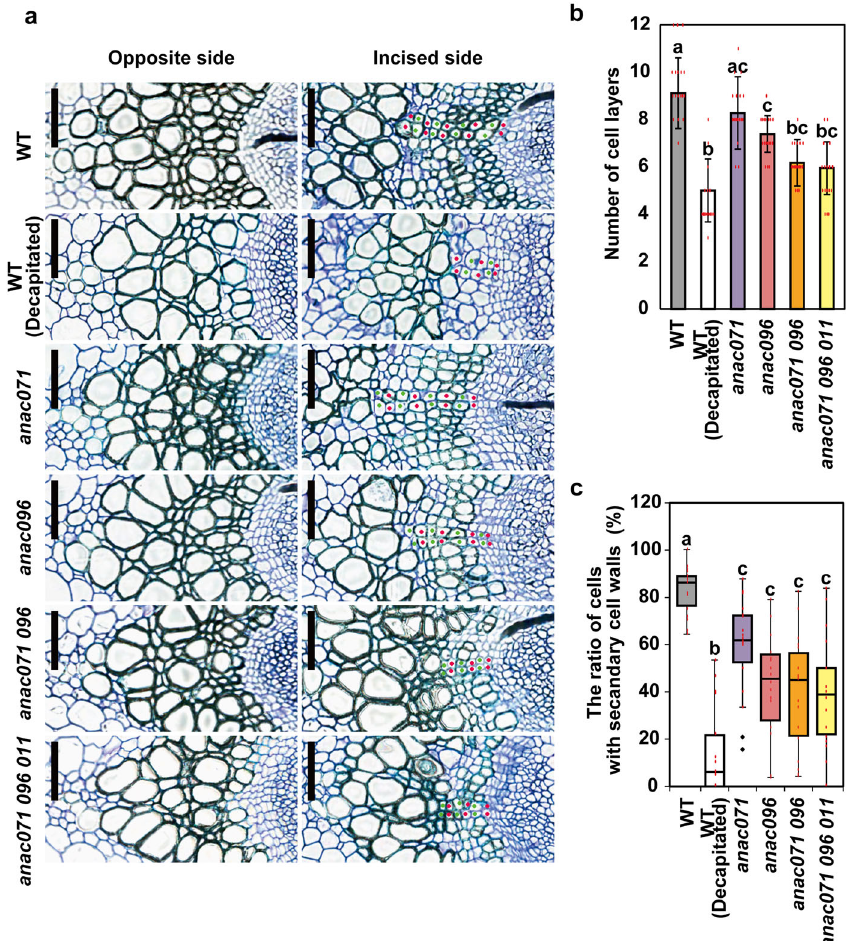
Fig. 4 Histological observation of the secondary xylem in incised stems of anac mutants. a Thin cross-sections of vascular tissue at the upper end of the incision at 7 DAI. Left, opposite side; right, incised side. Layers of periclinally divided cells were counted as red and green dots on the incised side (bottom). Scale bars = 100 μ m. b Bars are the mean number of cell layers at 7 DAI ( n = 18 from 9 plants). Different letters indicate statistically signi fi cant differences ( P < 0.05; Tukey ’ s test). c Boxplots showing the ratio of cells with secondary cell walls in the cell layer. Statistical analysis was performed using the Steel – Dwass test ( P <